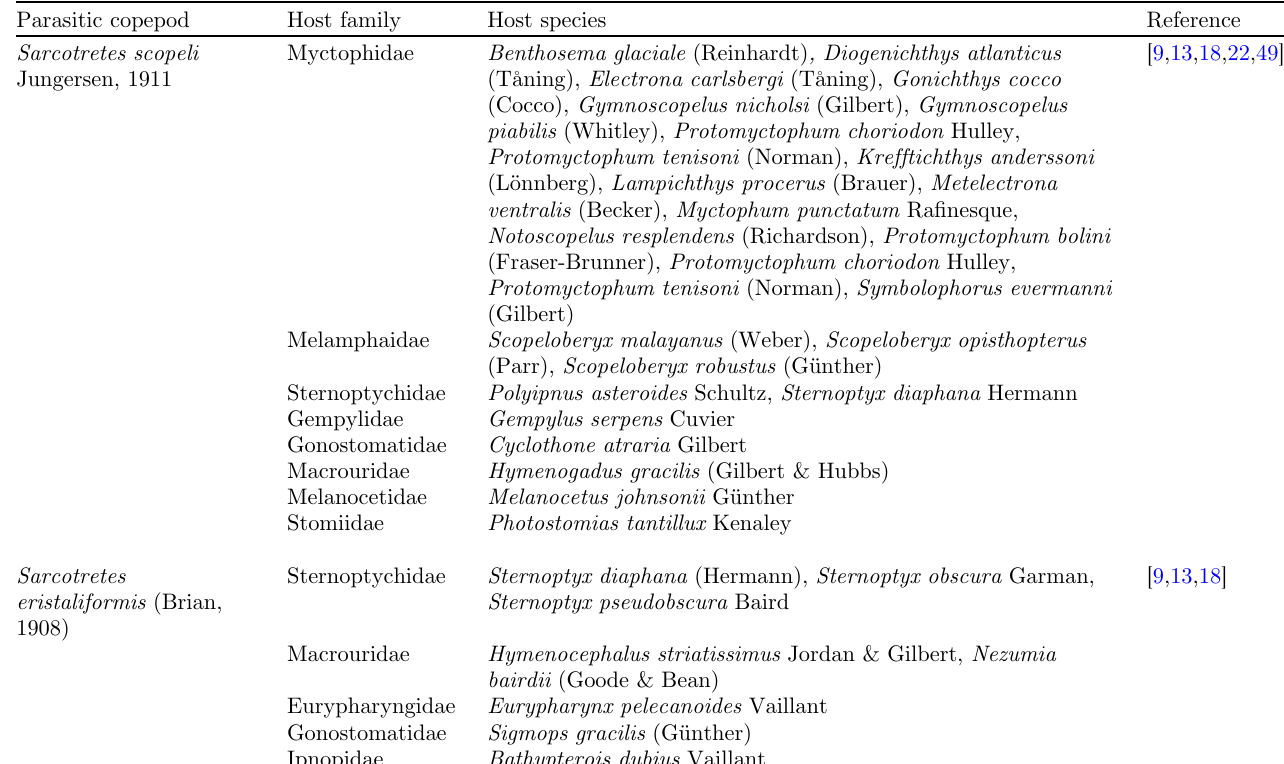
Table 2. Host-parasite relationships of pennellid copepods infecting deep-sea fi sh. Scienti fi c names of fi sh hosts are based on FishBase (2017)